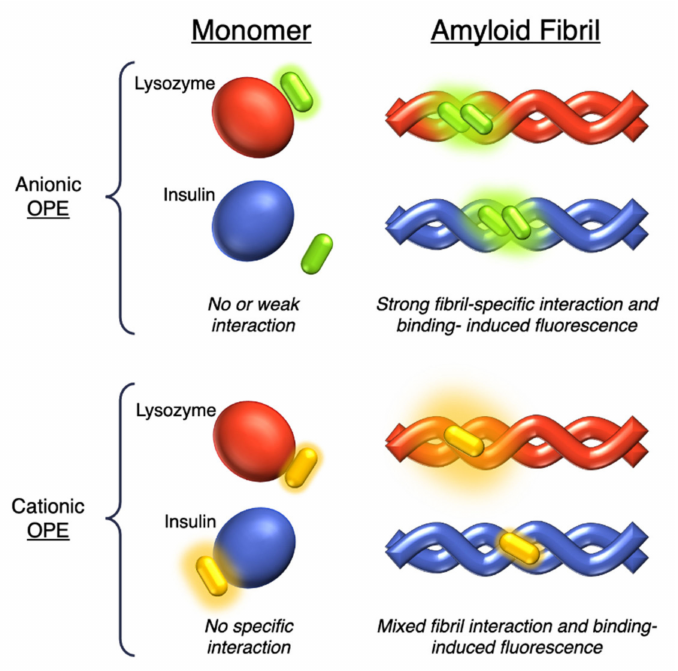
Figure 5. Schematic representation of the sensing modes of anionic 19c (in green) and cationic 18d - f (in yellow) OPEs towards lysozyme (in red) and insulin (in blue) monomers and